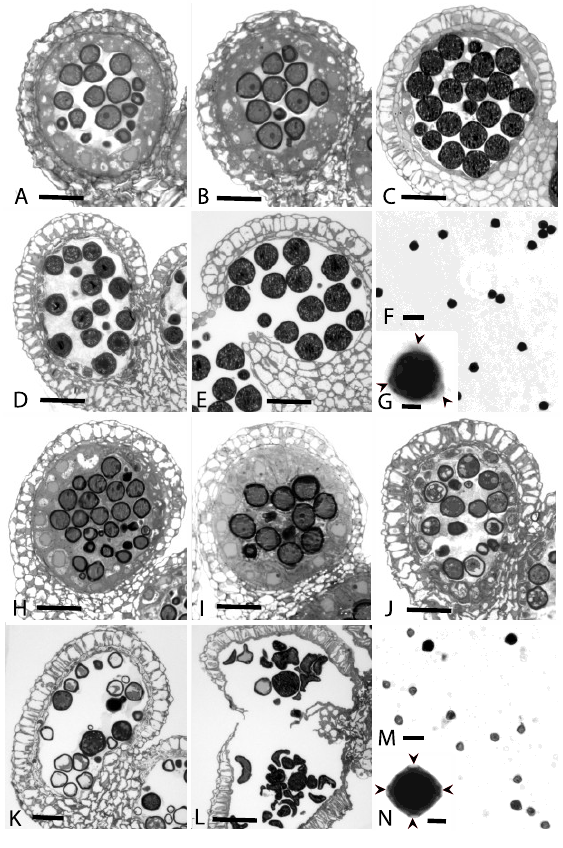
Figure 1. One-μm thick cross sections through male-fertile (MF = A–E) and ms5ms5 (ms = H–L) anthers depicting stages from early-mid microspores through pollen dehiscence, and anther squashes showing both normal (MF = F and G) and aborted or abnormal (ms = M and N) microspores/pollen from both lines. ( A ) MF = mid-microspore stage with tapetum; ( B ) MF = late-microspore stage with tapetum; ( C ) MF = pollen stage with disintegrating tapetum; ( D ) MF = pollen stage with disintegrated pollen; ( E ) MF = late pollen stage near dehiscence. Adjacent locules have fused; ( F ) MF = anther squash showing viable, stained pollen grains; ( G ) MF = single tricolporate pollen grain with three arrowheads pointing to pore regions; ( H ) ms = mid-microspore stage with tapetum; ( I ) ms = mid- to late-microspore stage with tapetum; ( J ) ms = late-microspore/early pollen stages showing both aborting microspores and enlarged pollen; ( K ) ms = late-microspore stage with many aborted microspores, an enlarged pollen, and a disintegrated tapetum; ( L ) ms = disintegrated and collapsed microspores and pollen from two adjacent, fused locules. Tapetum is absent and anther wall has split open; ( M ) ms = anther squash showing non-staining, non-viable microspores and several abnormal, engorged enlarged pollen; ( N ) ms = single, engorged pollen with four arrowheads pointing to four colpi. Scale bars = 40 μm on A-E, H-L; 50 μm on F and M; and 25 μm on G and